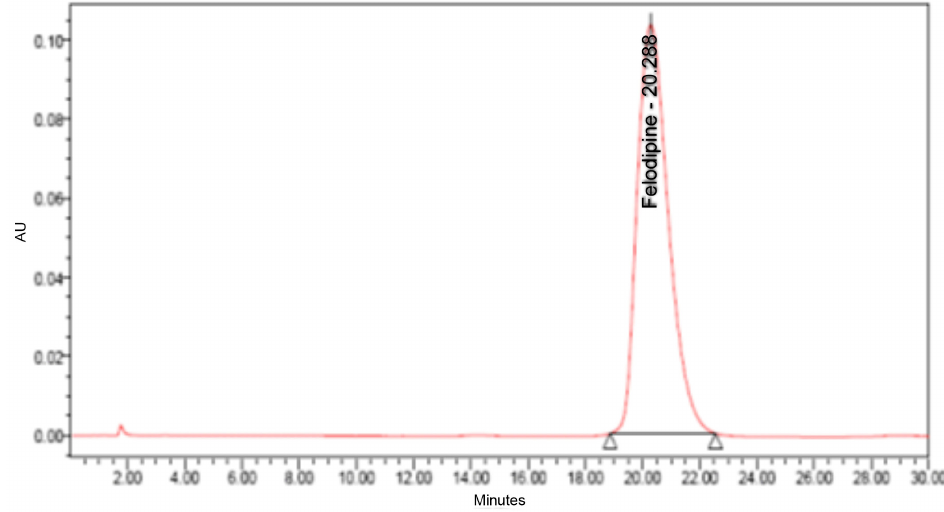
FIGURE 1 – HPLC Chromatogram of standard